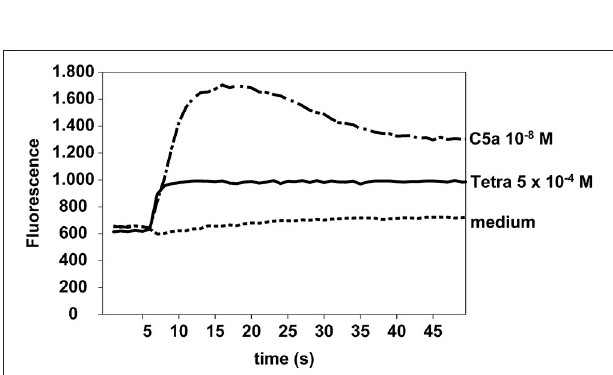
FIGURE 6 | Tetracycline hydrochloride induced calcium influx. Tetracycline hydrochloride 5 × 10 − 4 M and C5a (10 − 8 M, positive control) but not medium induced a significant calcium influx in eosinophils at a very early stage. Cellular fluorescence was recorded per second for 50s. Fluo4-AM assay. Aside from inhibition of matrix metalloproteinases (23) some tetracycline analogues have been reported to act as inducers of apoptosis in various cancer cells (56–60). However, the precise apoptotic mechanisms are far from being understood. In this study, we showed that tetracycline hydrochloride produced an early increase in loss of mitochondrial membrane potential